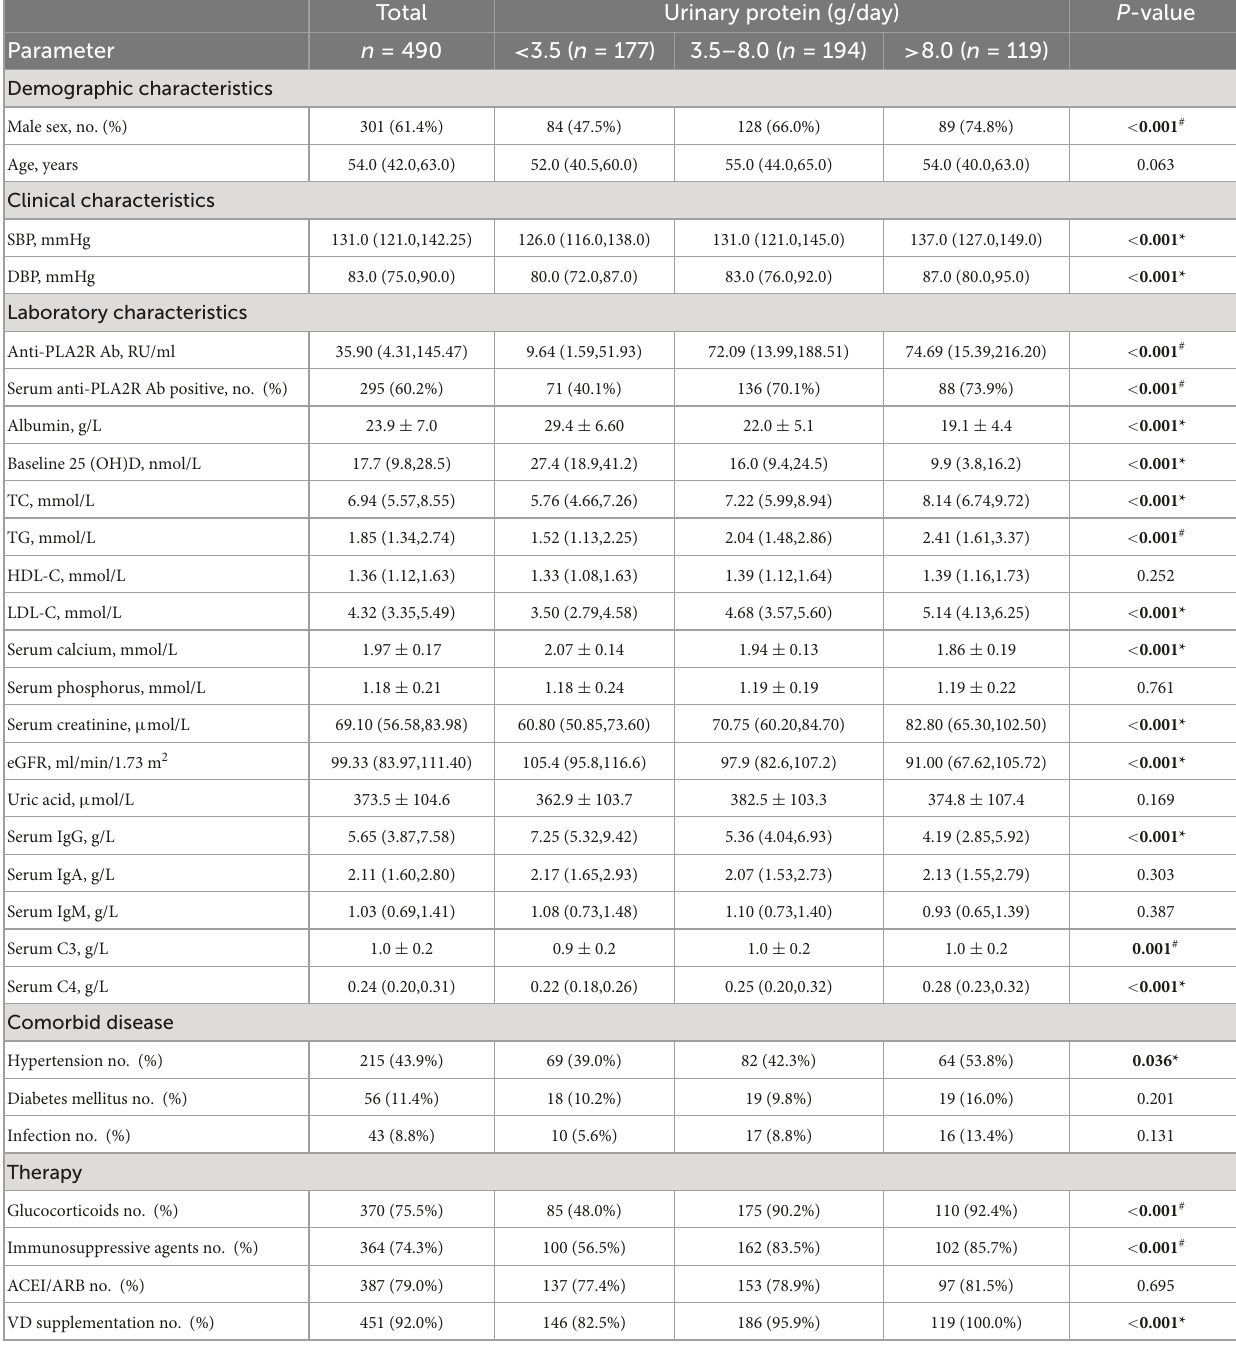
TABLE 1 Baseline characteristics of patients with different levels of proteinuria. Total Urinary protein (g/day)